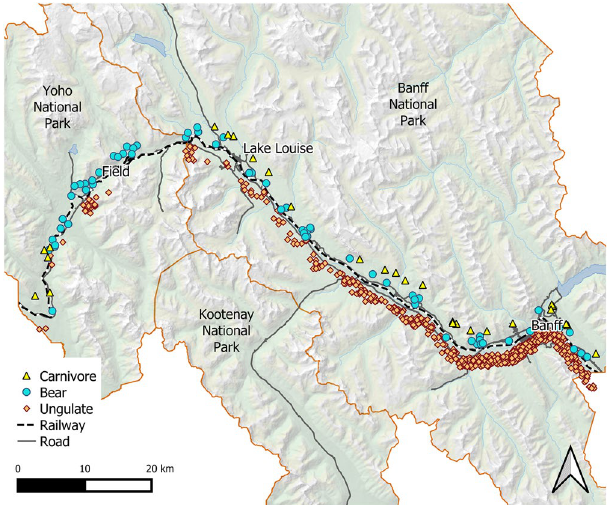
Figure 1. Location of Banff and Yoho National Parks, Canada, the railway track and roads that pass through them, and the sites of mortalities (offset from the rail) for three guilds of mammals recorded with handheld GPS between 1995 and 2018. The map was created by the authors with QGIS (version 3.10.0 https